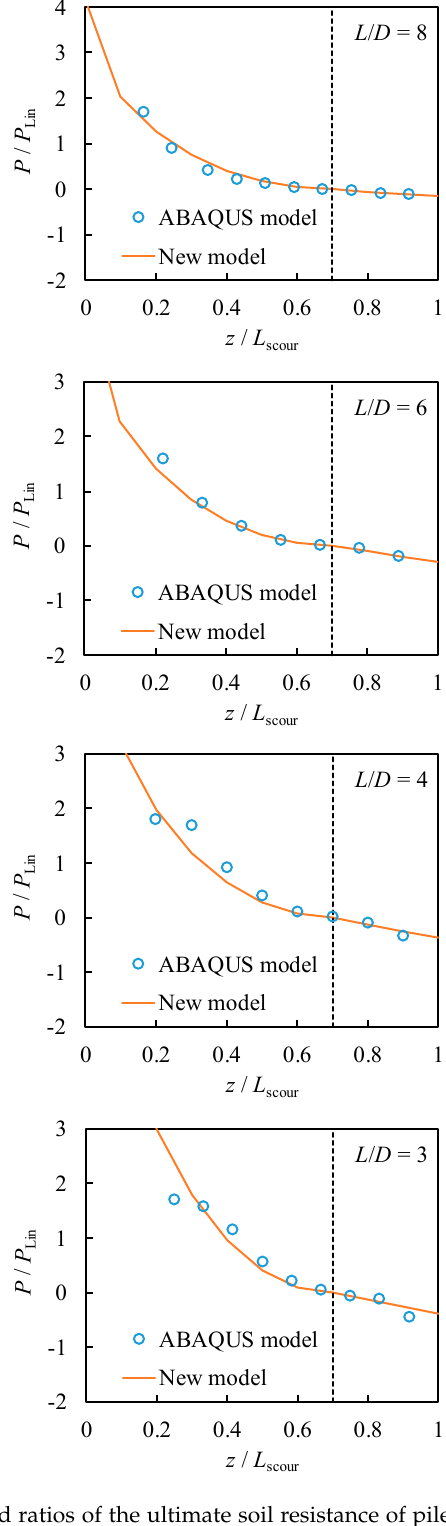
Figure 12. Ratios of the initial stiffness and ratios of the ultimate soil resistance of pile ‒ soil scour models at various depths.